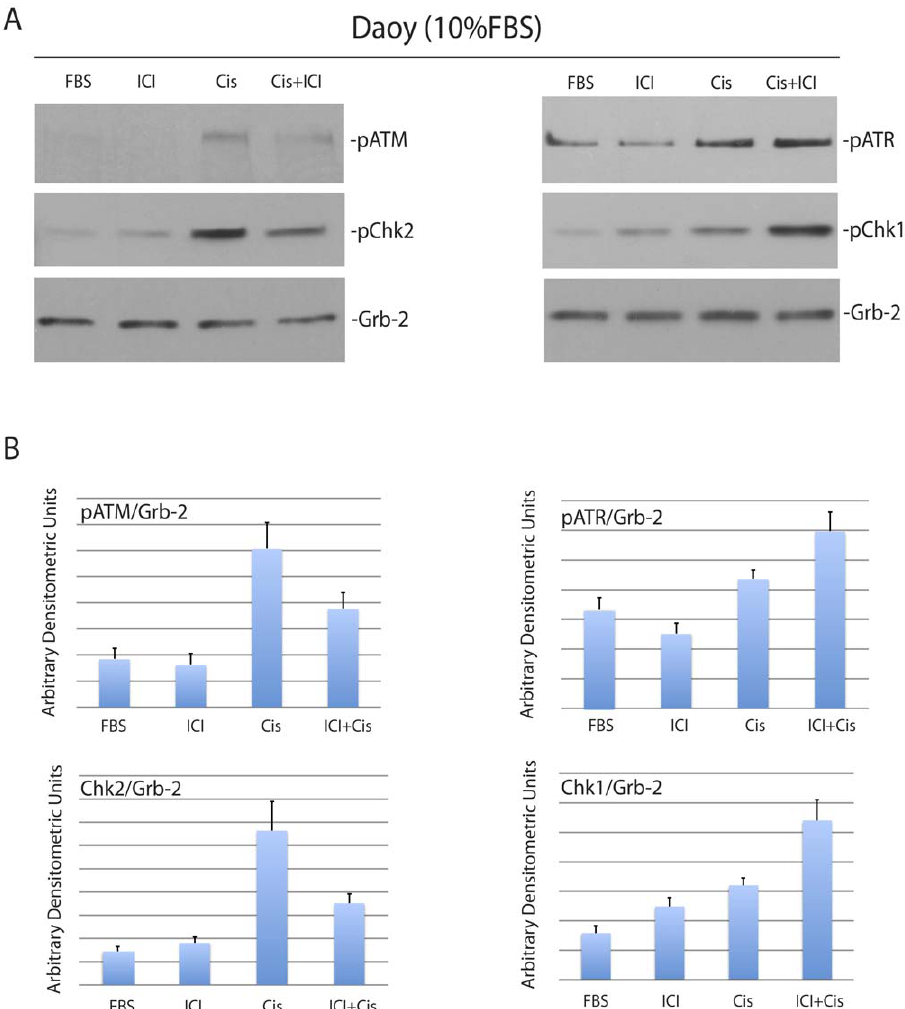
Figure 4. Inhibition of ER b modulates cisplatin-induced phosphorylation of cell cycle checkpoint proteins. Panel A: Western blot analyses showing levels of the phosphorylated ATM, ATR, Chk1 and Chk2 in constitutively growing Daoy cells (10%FBS) treated with cisplatin (1 m g/ ml) in the presence (Cis + ICI) or absence (Cis) of ICI182,780 (10 m M). The cells without treatment (FBS), or cells treated with ICI182,780 only (ICI) were used as controls. Panel B: Densitometry of Western blots depicted in Panel A evaluated by EZQuant-Gel 2.17 software. Levels of pATM, pATR, pChk1 and pChk2, were normalized with the corresponding levels of Grb-2. Data represent averages obtained from densitometric measurements of 3 blots with standard deviation and each band was normalized with corresponding loading control,